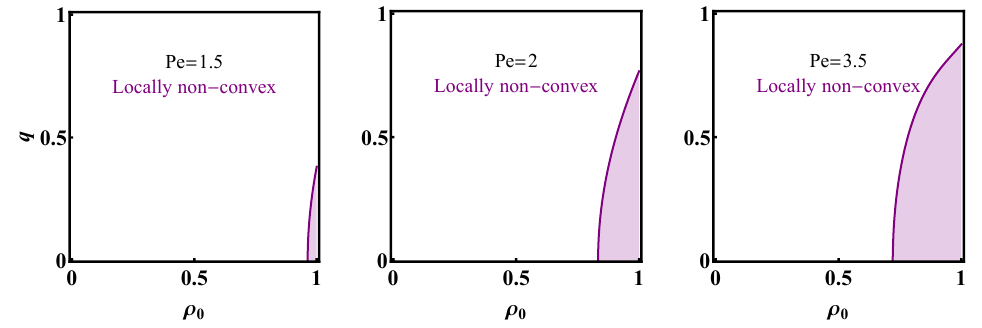
Figure 3: The emergence of local non-convexity of I (cid:112) Pe > Pe ∗ = 2. The boundary of this region, marked by a purple line is given by = 0 with h the implicit relation h given in (31) together with 0 0